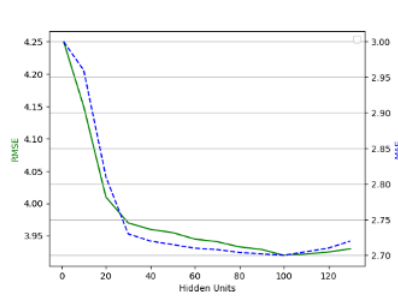
Fig. 4. Changes in RMSE and MAE of the sensor network prediction.